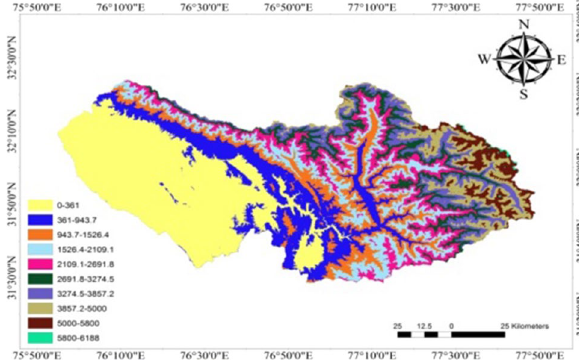
Fig. 2 a DEM map, b slope map, c LULC map and d soil map of Beas basin Table 1 SWAT LULC classes corresponding to LULC classes from